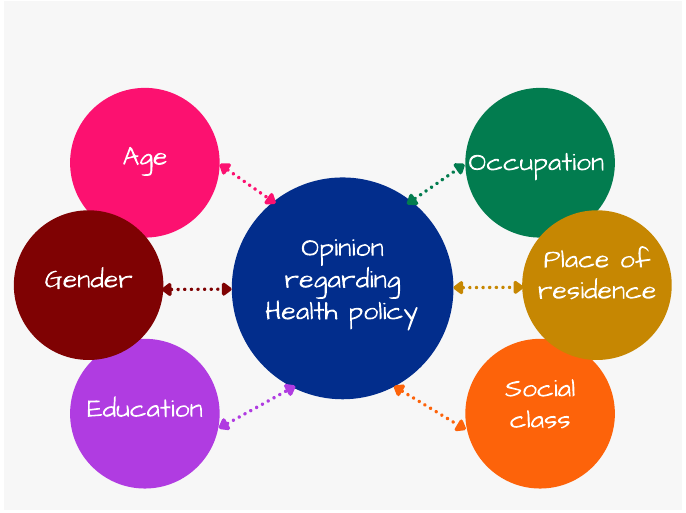
Figure 1. An overview of the main factors affecting health policy. Source: Authors’ design. To predetermine and shape health systems, outcomes, and policy, a crucial factor is represented by gender [41]. Gender equity represents a vital factor to influence the quality of public healthcare systems and their outcomes [42]. Women are more cautious [43], risk-averse [44,45], fatalistic [46], and loss averse [12]. There are also differences between gender in risk-taking behaviour in the case of leaders [47]. Reporting on a group, male leaders assume high risks, while female leaders assume small risks